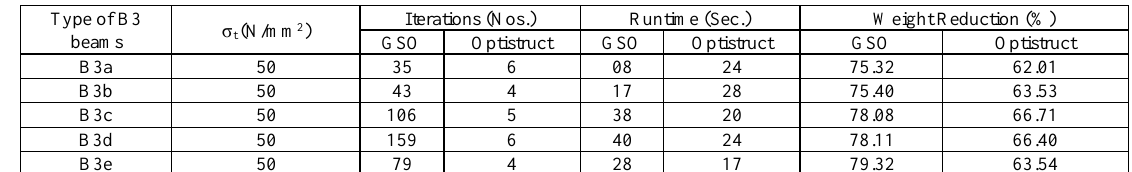
Figure 8. Schematic representation of beam B3. Table 4. Parameters for B3a, B3b, B3c, B3d and B3e with iterations, runtime and percentage weight reduction to reach the optimized shape.